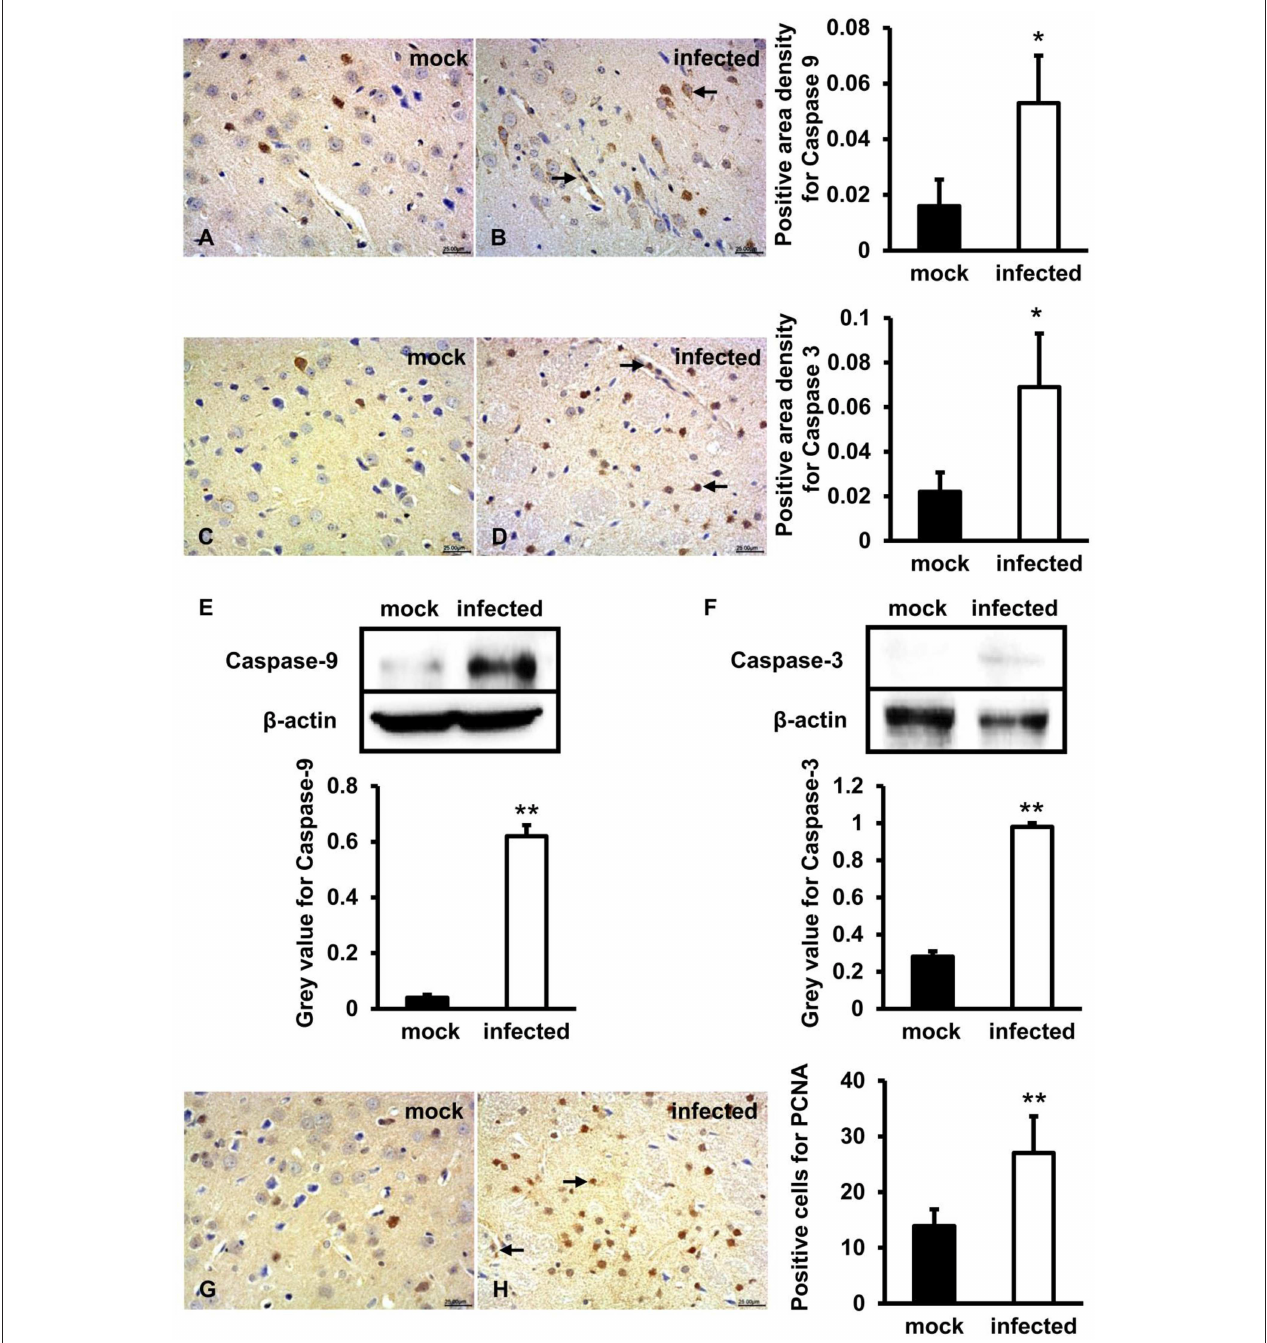
FIGURE 4 | Mitochondrial apoptotic signaling was activated during HEV infection. HEV-RNA positive brain tissues collected on 14, 21, and 28 dpi were used for the immunohistochemistry study of caspase-9 (rabbit polyclonal IgG), caspase-3 (rabbit polyclonal IgG) and PCNA (rabbit polyclonal IgG). Goat anti-rabbit IgG was chosen as secondary antibody. The positive signal was measured via the Motic Med 6.0 CMIAS Image Analysis System. (A–D) Immunohistochemistry study showed that expression levels of activated caspase-9 and caspase-3 were expressed in neuronal cells and vascular endothelial cells of the brain tissue, with higher amount in HEV infected animals compared with mock animals (* p < 0.05). (E,F) For western blot, HBMVECs were inoculated with 300 MOI HEV for 48h and HEV-negative homogenate served as control. Data showed that expression levels of cleaved caspase-9 and caspase-3 were significantly increased in HBMVECs infected with HEV compared with mock group (** p < 0.01). (G,H) Positive signal of PCNA was detected in glial cells and vascular endothelial cells, with significantly higher level in HEV infected brain sections compared with mock group (** p < 0.01). For western blot, gray value was analyzed with ImageJ to quantitatively analyze the expression levels of targeted proteins according to the level of exposure gray (resolution). Data were finally normalized to the expression of anti- β -actin.